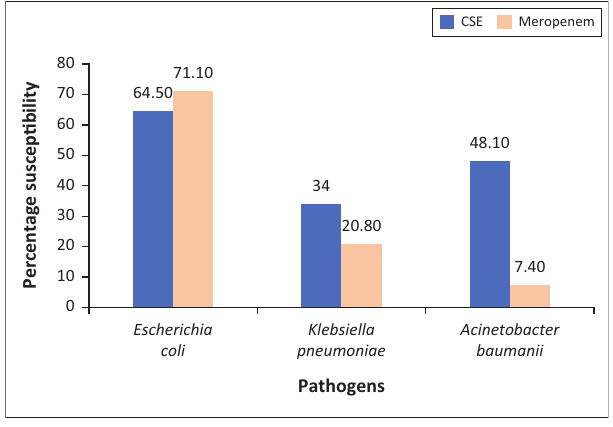
FIGURE 3: In vitro antibiotic susceptibility pattern for most common Gram- negative isolates against ceftriaxone-sulbactam-disodium edetate and Meropenem ( n = 156) at a hospital in Delhi, India, February 2017 to June 2017.